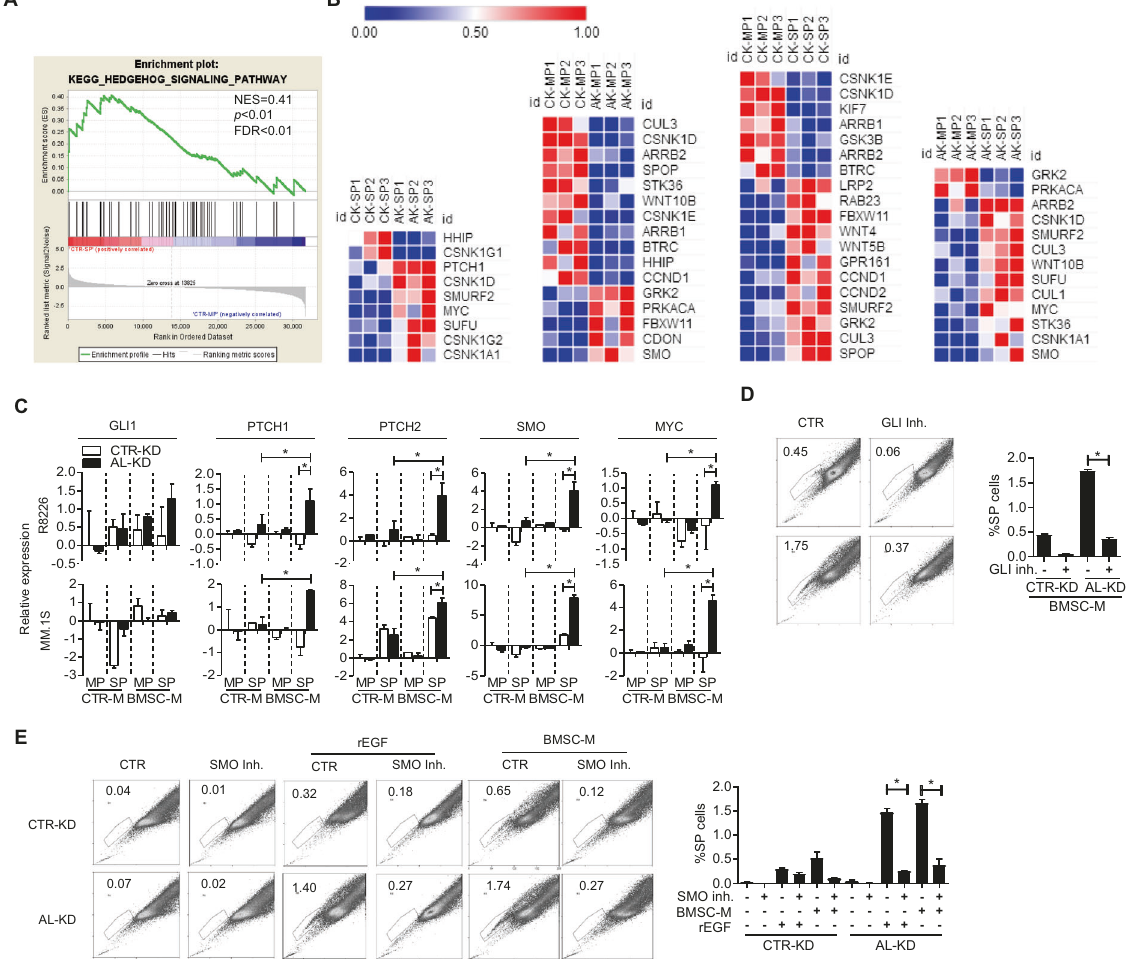
Fig. 3 ALCAM suppresses the hedgehog pathway activation. A GSEA analysis showing the hedgehog pathway gene enrichment in SP and MP cells; B Heatmap showing differentially regulated hedgehog pathway gene expression. From left to right are comparisons of CK-KD SP vs. AL-KD SP, CK-KD MP vs. AL-KD MP, CK-KD MP vs. CK-KD SP, and AL-KD MP vs. AL-KD SP. p < 0.05 for all listed genes. C Reverse transcriptional quantitative PCR for hedgehog pathway gene expression in CTR-KD versus AL-KD MM cells. D Hoechst staining of CTR-KD or AL-KD RPMI8226 cells, cocultured with BMSC in the presence of GLI inhibitor (GNAT61, 10 μΜ ) and the result quanti fi cation (below panel). E Hoechst staining of CTR-KD or AL-KD RPMI8226 cells, cocultured with BMSC or recombinant EGF protein (10 ng/ml) in the presence of SMO inhibitor (cyclopamine, 50 nM) for 24 h and the result quanti fi cation (right panel). Data are the mean of three independent experiments in three replicates. * p <